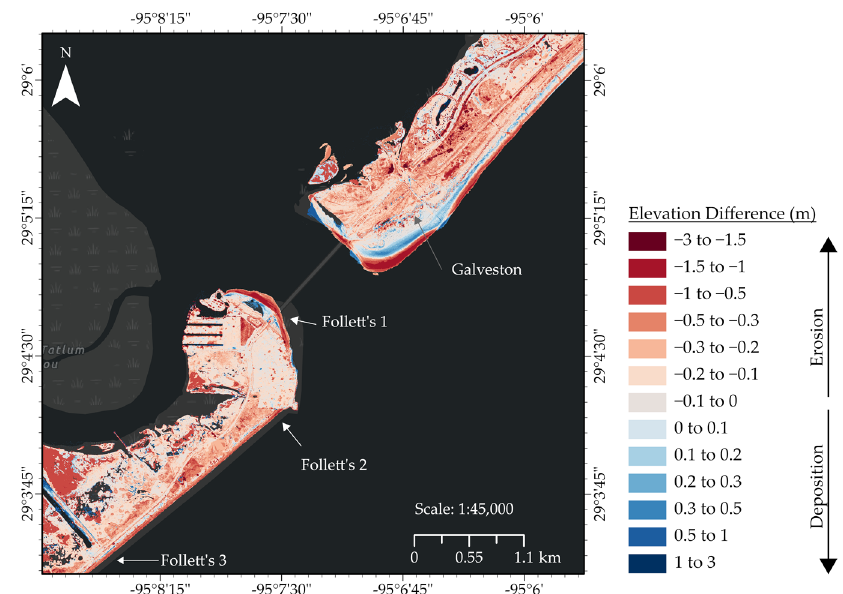
Figure 8. Elevation difference map for the full extent of the 2016 and 2017 San Luis Pass. Post-Harvey 2017 data were collected between 31 August and 29 October. Erosion to Follett’s Site 1 foredune rear-slope and ridge height varied with values up to 0.5 m seen in Figure 9b. The pre-storm shoreline, berm, and backbeach in Figure 9a have scraped away between data sets, visualized by a concave profile in Figure 9c. Vegetated hummocky coppice dunes were eroded vertically, and up to 0.7 m of sediment was deposited along the post-storm berm. Scarped shorelines and backbeach areas were observed along Follett’s Site 2 (Figure 10b) and in the subtle post-storm concave beach profile in Figure